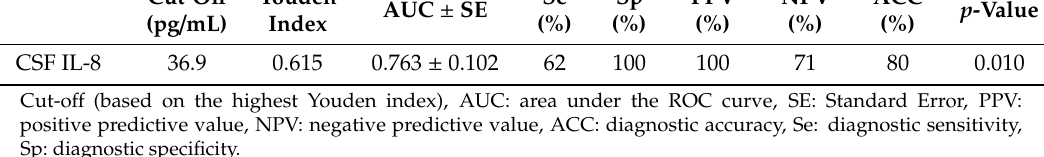
Table 7. The optimal cut-o ff point of CSF IL-8 to predict a larger brain aneurysm size ( ≥ 5.4 mm). Cut-O ff